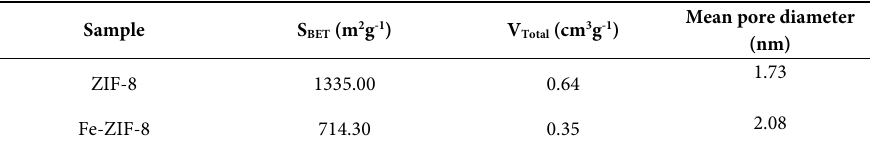
Table 2 Textural data of the